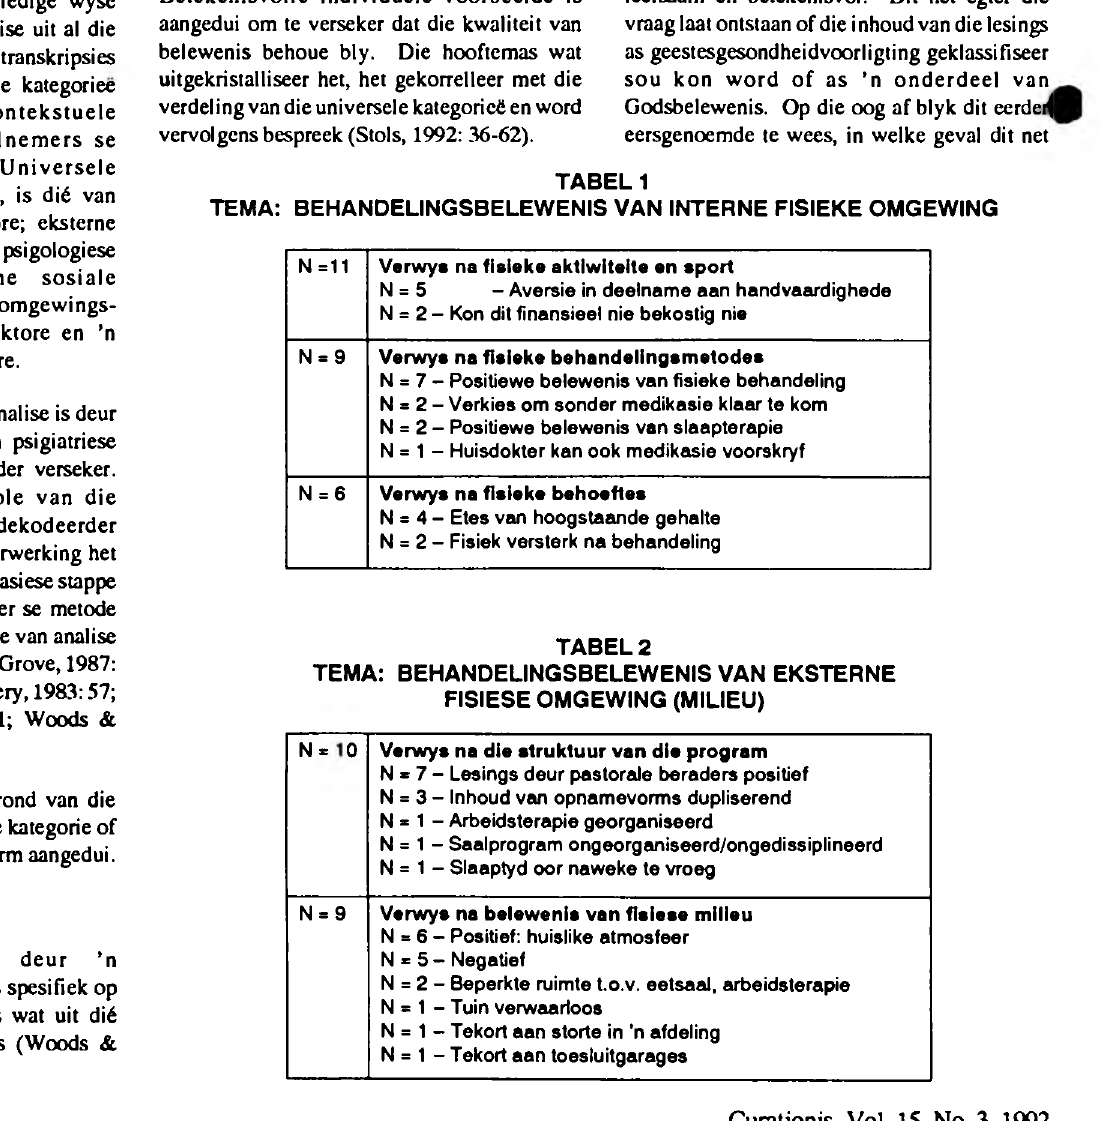
TEMA: BEHANDELINGSBELEWENIS VAN EKSTERNE FISIESE OMGEWING